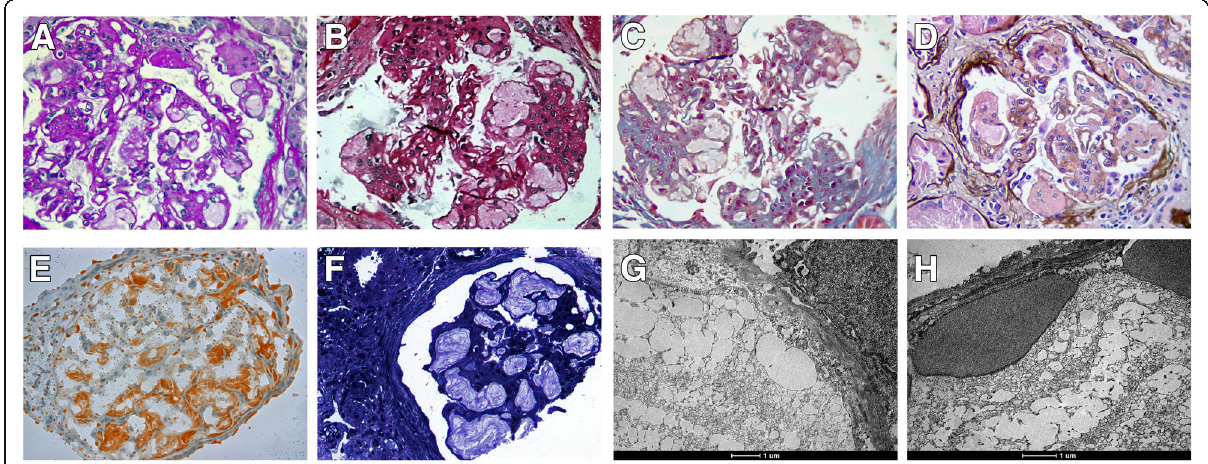
Fig. 1 Kidney biopsy. Case 2. A , B , C , D Glomerulus with increased mesangial matrix and cellularity, displaying open capillary loops filled with amorphous, acellular, lipidic and pale material observed on PAS, Picrosirius, Masson ’ s trichrome and Jones silver methenamine staining, respectively; and E Oil Red staining showing lipidic material within the glomerular capillaries (400X). Case 1. F Toluidine blue staining revealing glomerulus with intense luminal deposition of lipidic material. Cases 2 ( G ) and 1 ( H ): Transmission electron microscopy obtained after re-inclusion of paraffin-embedded material in resin, stained with osmium tetroxide and ruthenium red, showing lipoprotein pseudo-thrombi constituted of vacuolized material inside the capillary loops (16.500X